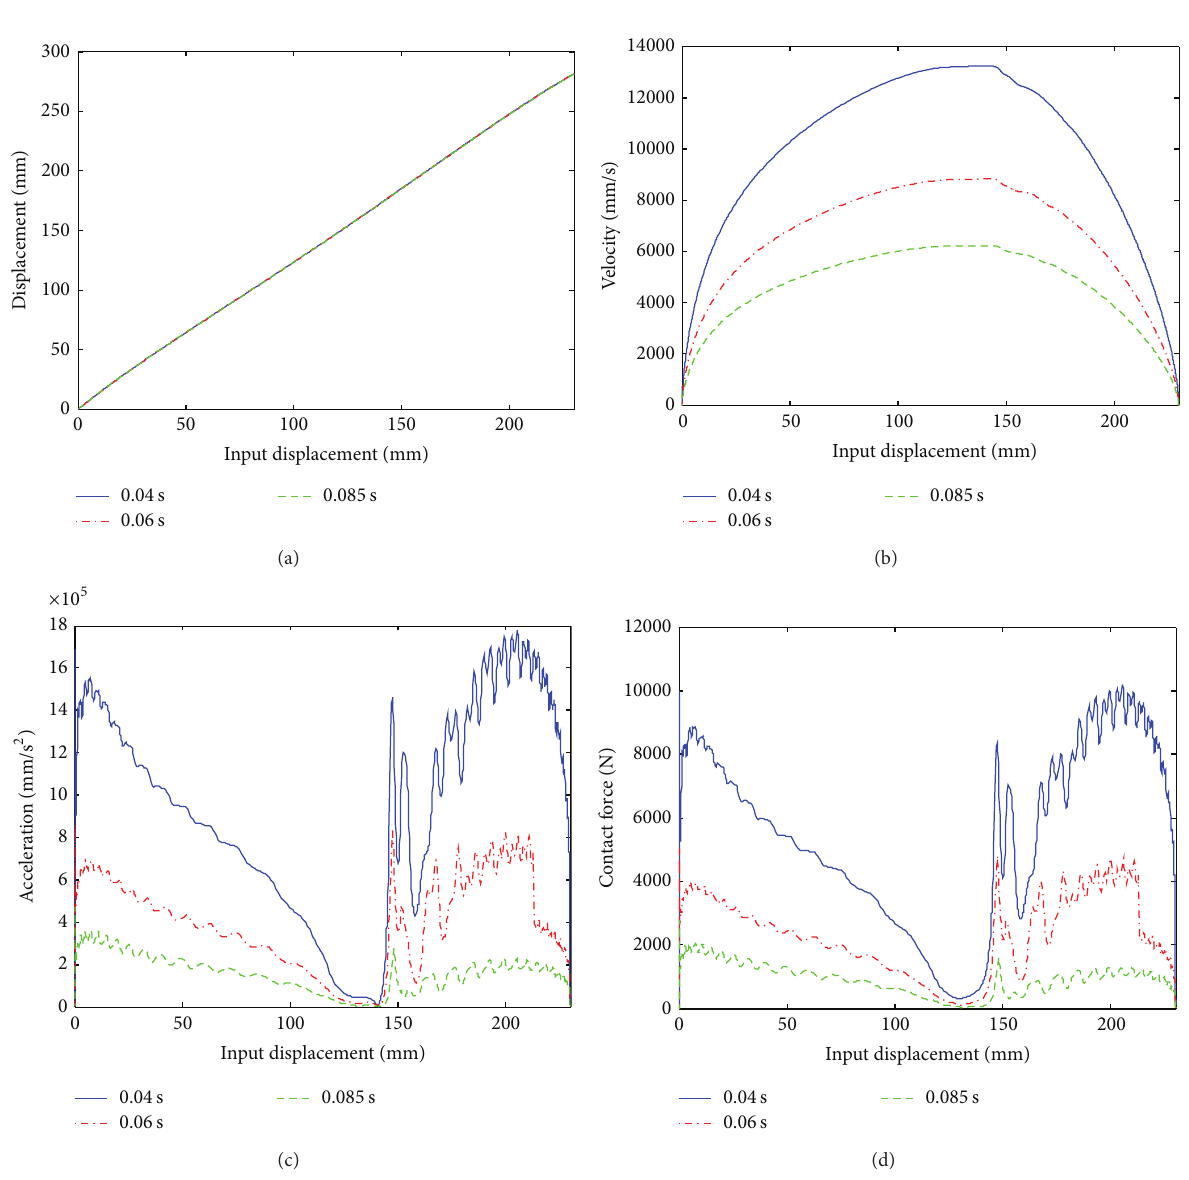
Figure 17: Responses for different input speeds: (a) displacement, (b) velocity, (c) acceleration, and (d) contact